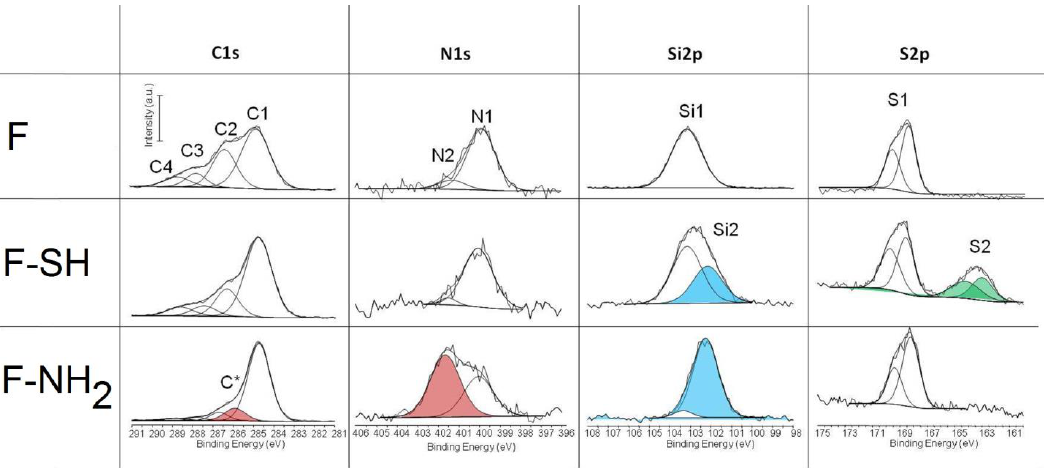
Figure 6. Best fitting of C1s, N1s, Si2p and S2p X-ray photoelectron spectroscopy (XPS) peaks.